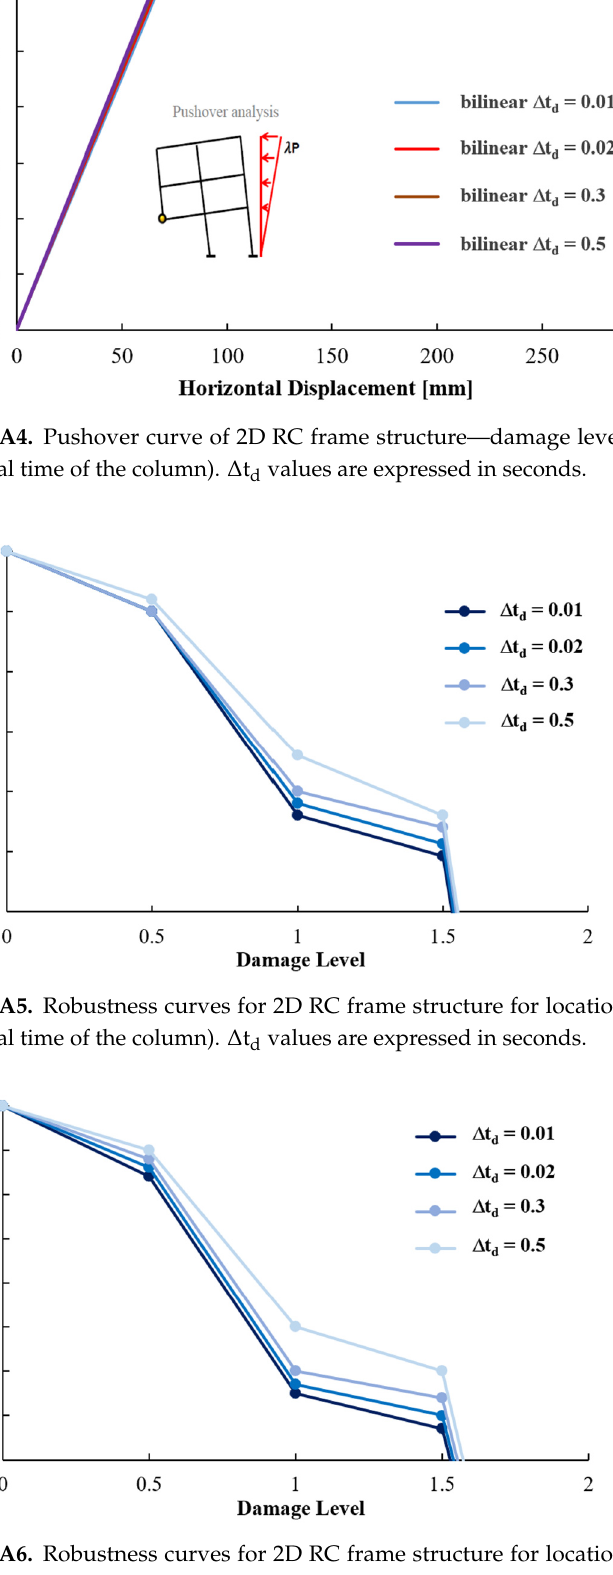
Figure A6. Robustness curves for 2D RC frame structure for location 2: effect of variation of Δ t d (removal time of the column). Δ t d values are expressed in seconds.